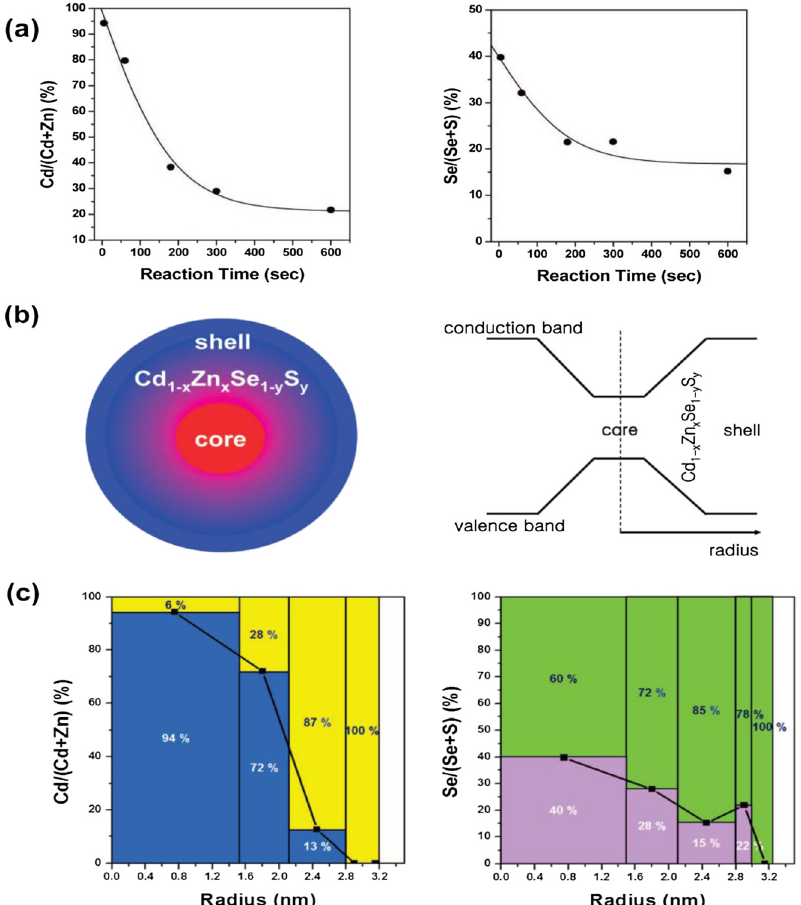
Figure 3: (a) Composition ratios of Cd-to-Zn and Se-to-S as a function of reaction time and (b) a schematic of the chemical composition (or electronic energy level) withinaquantumdot.(c)RatioofCdorZnto (Cd + Zn) and that of Se or S to Se/(Se + S) for each shell from the center of the quan- tum dot. Relative values of each component (Cd, Zn, Se, and S) in each shell are shown. The starting amounts were 0.4, 0.4, 4 and 4 mmol for Cd, Zn, Se and S correspond- ingly for (a – c)